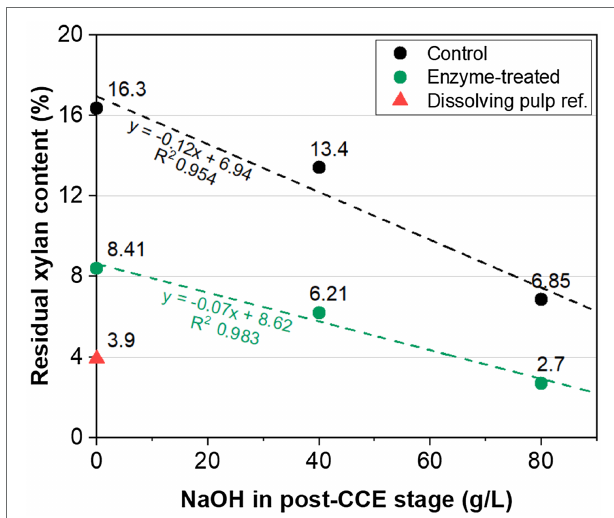
FIGURE 2 | Residual xylan content in eucalyptus kraft pulp versus NaOH dosage in CCE. The pulp was treated with O-X 0 -D 0 -HCE-X 1 -HCE-D 1 -CCE using enzymes (green) and without any enzymes (control, black). The NaOH concentration in the post-treatment CCE was 0, 40 or 80 g/l. CCE conditions: 35 ° C; 30 min. X 0 : GH11 xylanase and cellulase; X 1 : only GH11 xylanase. The value for a commercial pre-hydrolysis kraft (PHK) hardwood dissolving pulp is shown as reference (red triangle).